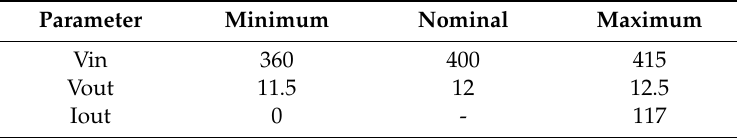
Table 3. Summary of converter design specifications.